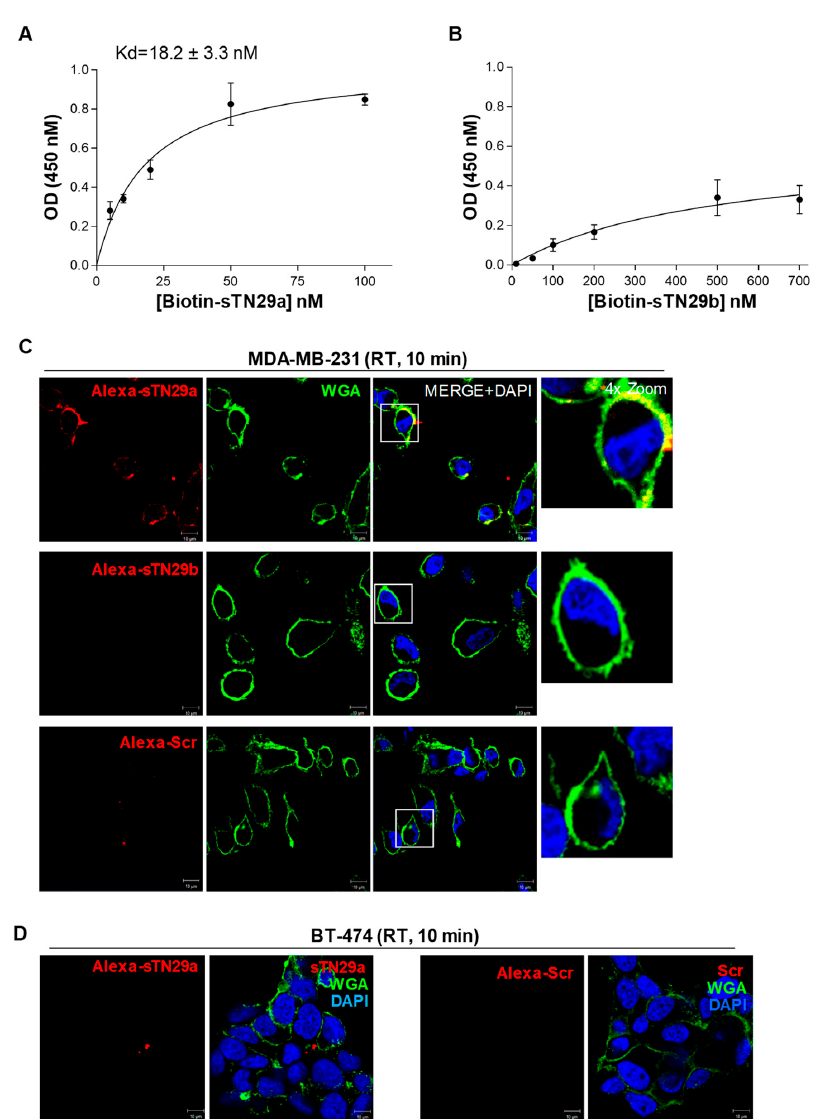
Figure 4. Cell binding of the sTN29 aptamer. Binding curves of the 5 ′ -biotinylated sTN29a ( A ) or sTN29b ( B ) on MDA-MB-231 cells for calculation of the apparent Kd of aptamer-cell interaction. Binding was analyzed using the streptavidin-biotin-based assay. Data shown are mean ± SD of three independent experiments. ( C , D ) Representative confocal images of MDA-MB-231 ( C ) and BT-474 ( D ) cells were incubated for 10 min at RT with the indicated Alexa 647-labeled aptamers. Alexa 647- labeled aptamer, WGA-488, and nuclei are visualized in red, green, and blue, respectively. All digital images were captured at the same setting to allow direct comparison of staining patterns. Magnification 63×, 1.0× digital zoom, scale bar = 10 μ m. At least three independent experiments were performed. In ( C ), co-localization results appear yellow in the merged images. Inset: 4× digital zoom.